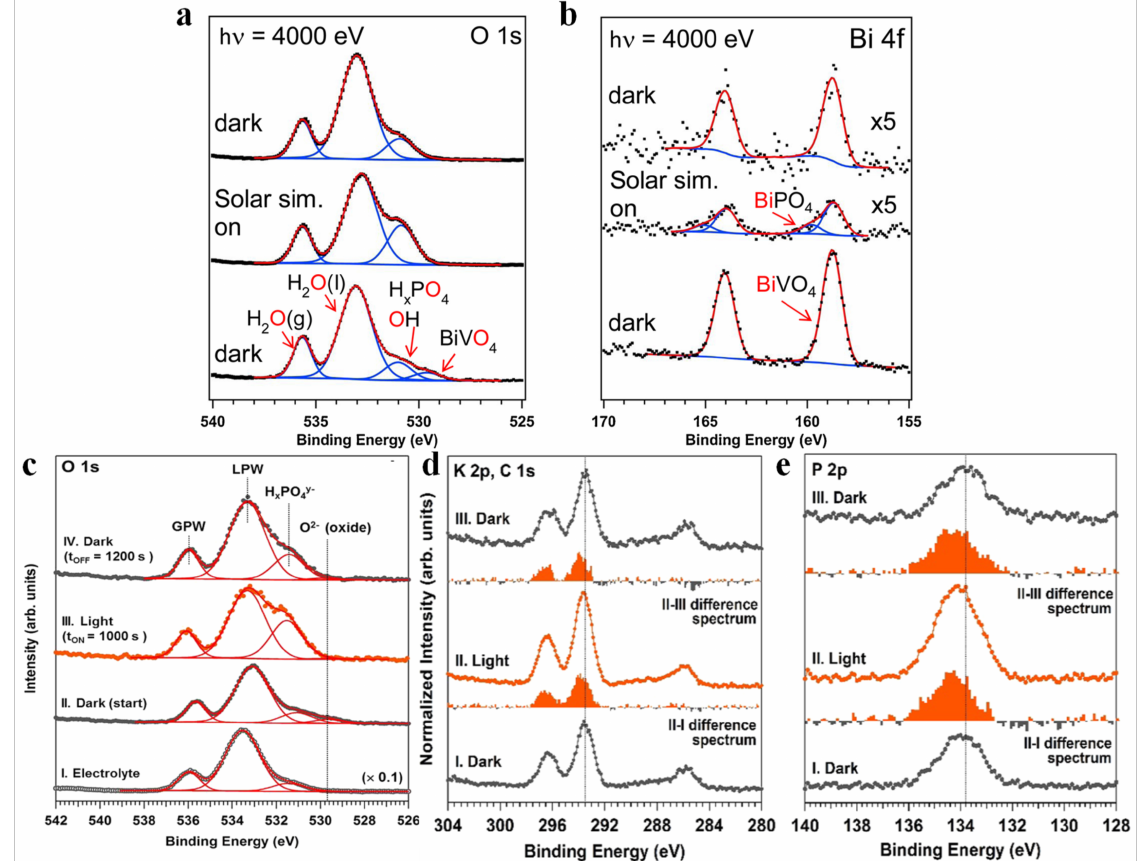
Figure 9. O 1s ( a ) and Bi 4f ( b ) spectra of a BiVO 4 thin film on FTO/glass under an approximately 21 nm thick potassium phosphate electrolyte at open circuit potential. Adapted with permission from ref. [127]. Copyright 2017 Elsevier B.V. In situ AP-HAXPES experiments performed on a polycrystalline BiVO4/liquid electrolyte interface. Selected O 1s spectra ( c ) and corresponding multipeak fitting procedure, I. KPi electrolyte only, II. The BiVO 4 /KPi electrolyte system initially in the dark, III. The BiVO 4 /KPi electrolyte system after 1000 s of illumination with a solar simulator, IV. The BiVO 4 /KPi electrolyte system 1200 s after returning to dark conditions. In situ AP-HAXPES experiments performed at room temperature and at p ∼ 17 Torr on a polycrystalline BiVO 4 /KPi aqueous electrolyte interface at the half-cell open circuit potential under illumination ( ∼ 0.92 sun) and dark conditions (h υ = 4.0 keV); K 2p and C 1s ( d ), and P 2p ( e ) photoelectron spectra. Adapted with permission from ref. [128]. Copyright 2017 American Chemical